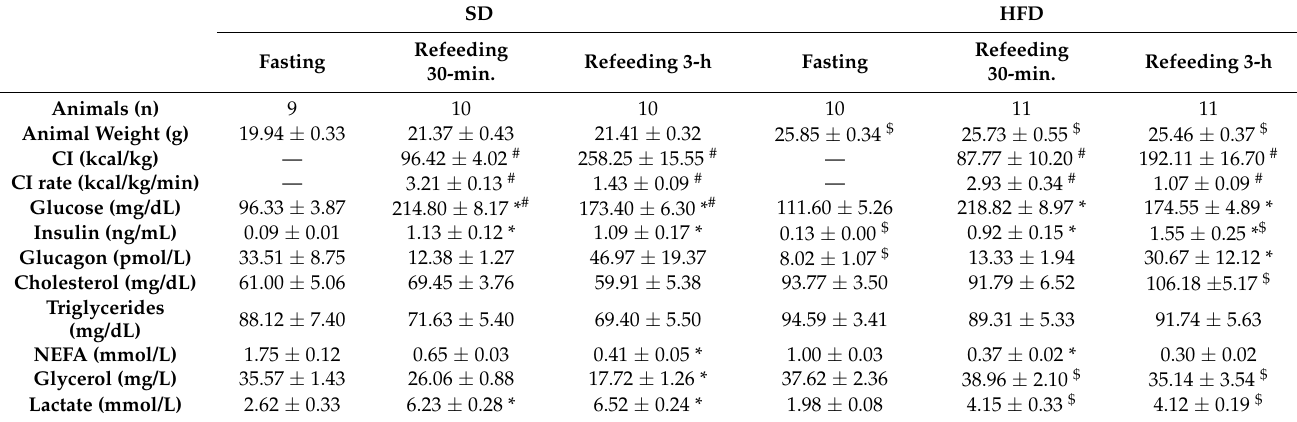
Table 1. Metabolic responses to fasting or refeeding in mice fed an SD or HFD. SD HFD Refeeding Fasting